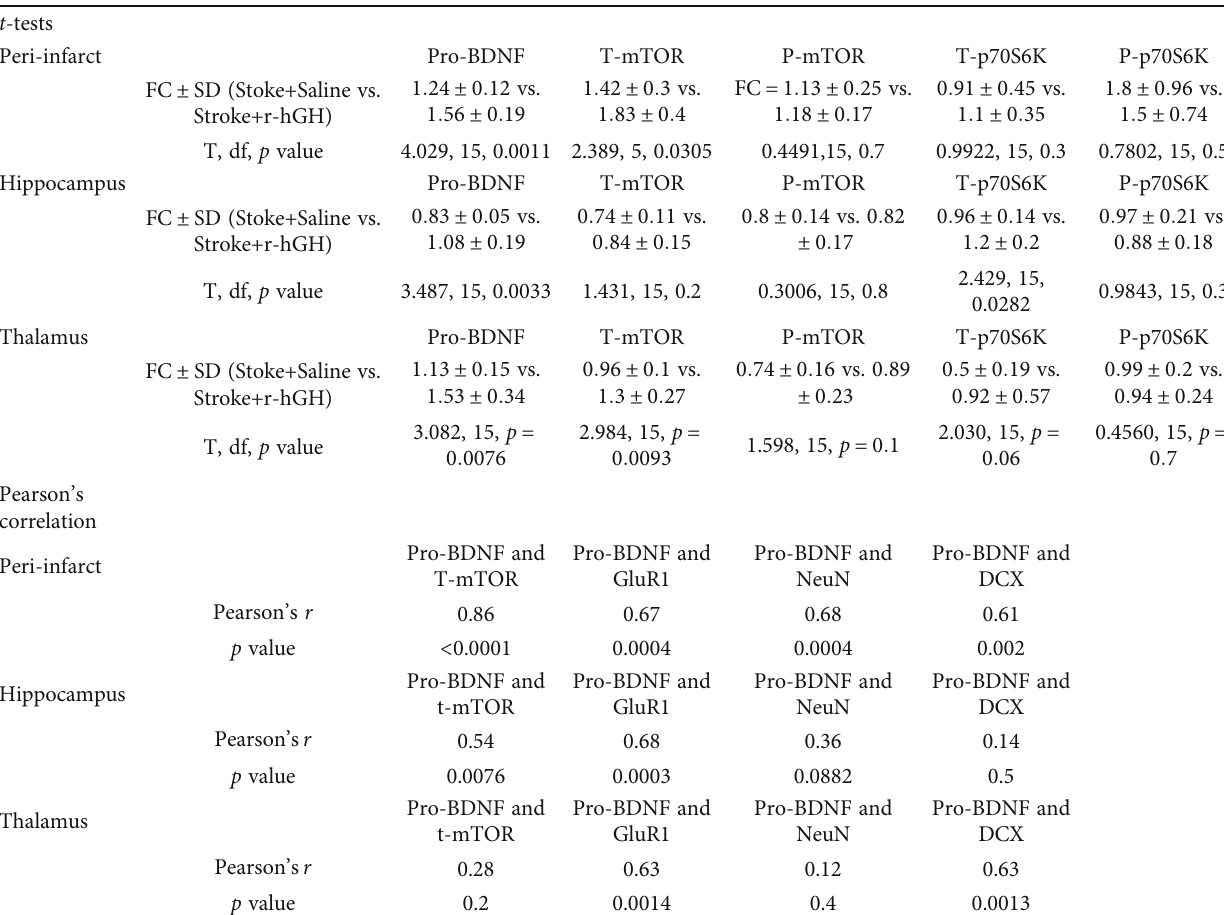
Table 2: t -test and Pearson ’ s results summary